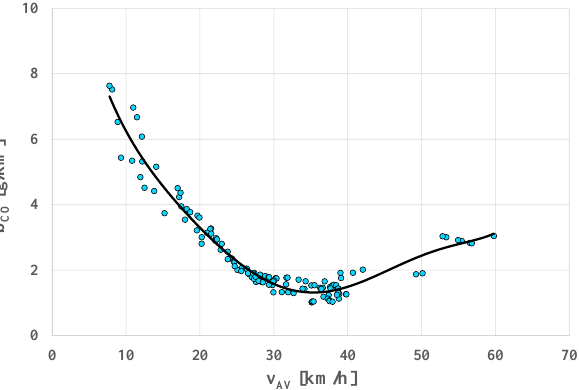
Fig. 12. Examples of vehicle velocity processes in fragments of the Malta test Figures 13–17 present the exhaust emission characteris- tics in the form of a dependence of the average specific distance exhaust emissions and the average specific dis- tance particle number on the average vehicle velocity in the Malta test. Fig. 15. Dependence of the average specific distance emission of nitrogen oxides on the average vehicle velocity in the Malta test